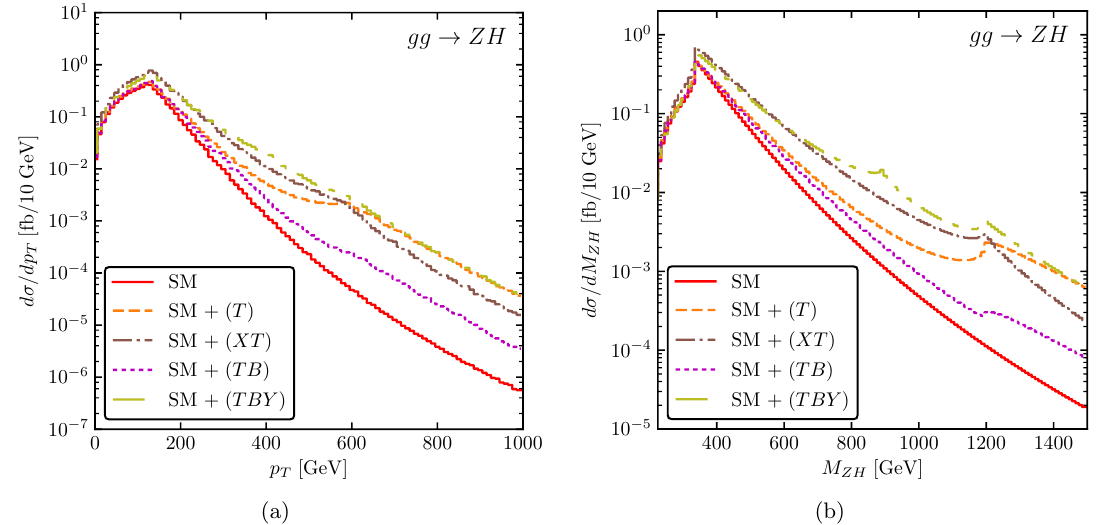
Figure 13 . Transverse momentum (a) and invariant mass (b) distributions in the SM for the gluon induced process compared to the SM with an additional VLQ multiplet The input parameters are m T = m B = 600 GeV for all representations other than ( TBY ), where m T = 600 GeV is chosen and m B = 447 : 08 GeV. The mixing angles are (cid:18) t = 0 : 5 for ( T ), (cid:18) t = 1 : 02 for ( XT ), (cid:18) t = 0 : 471 L R R for ( TB ), and (cid:18) t = 1 : 06 for ( TBY L